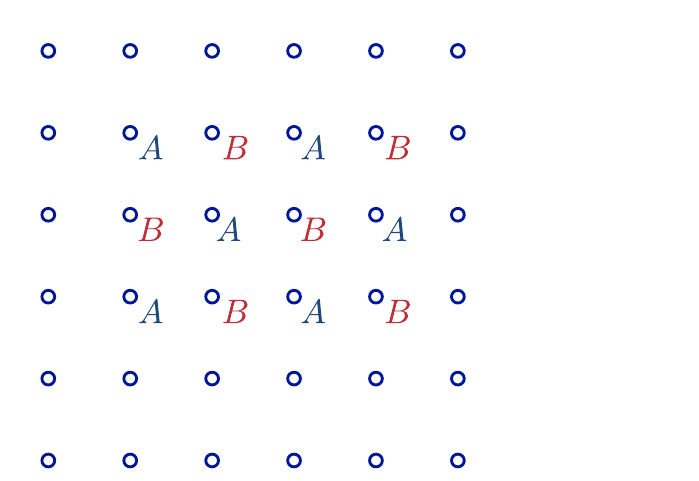
Figure 2.4: A square lattice can be divided into two inequivalent sublattices A and B . In the case of a perfect Néel antiferromagnet, the spins on the two sublattices point in opposite